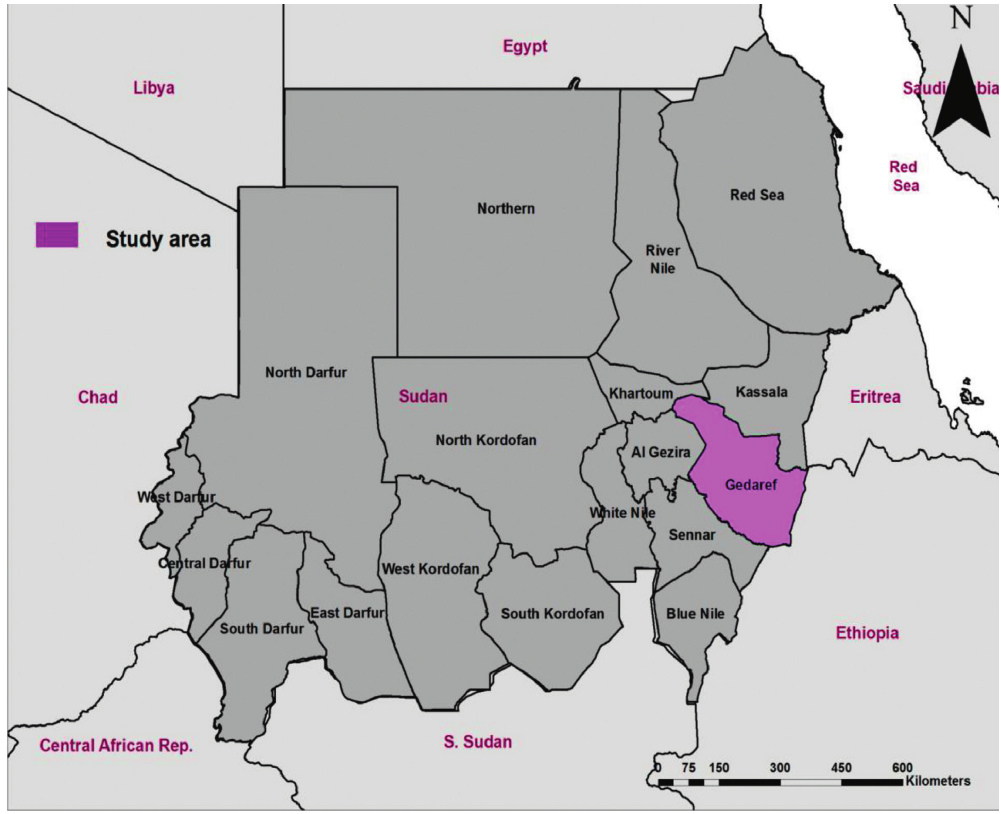
Figure 1: Map of Sudan showing the study area (Gadarif state) where serum samples were Table 1: Multivariate analysis for the association between potential risk factors and BTV seropositivity among camels in Gadarif state, eastern Sudan, using chi-square test.